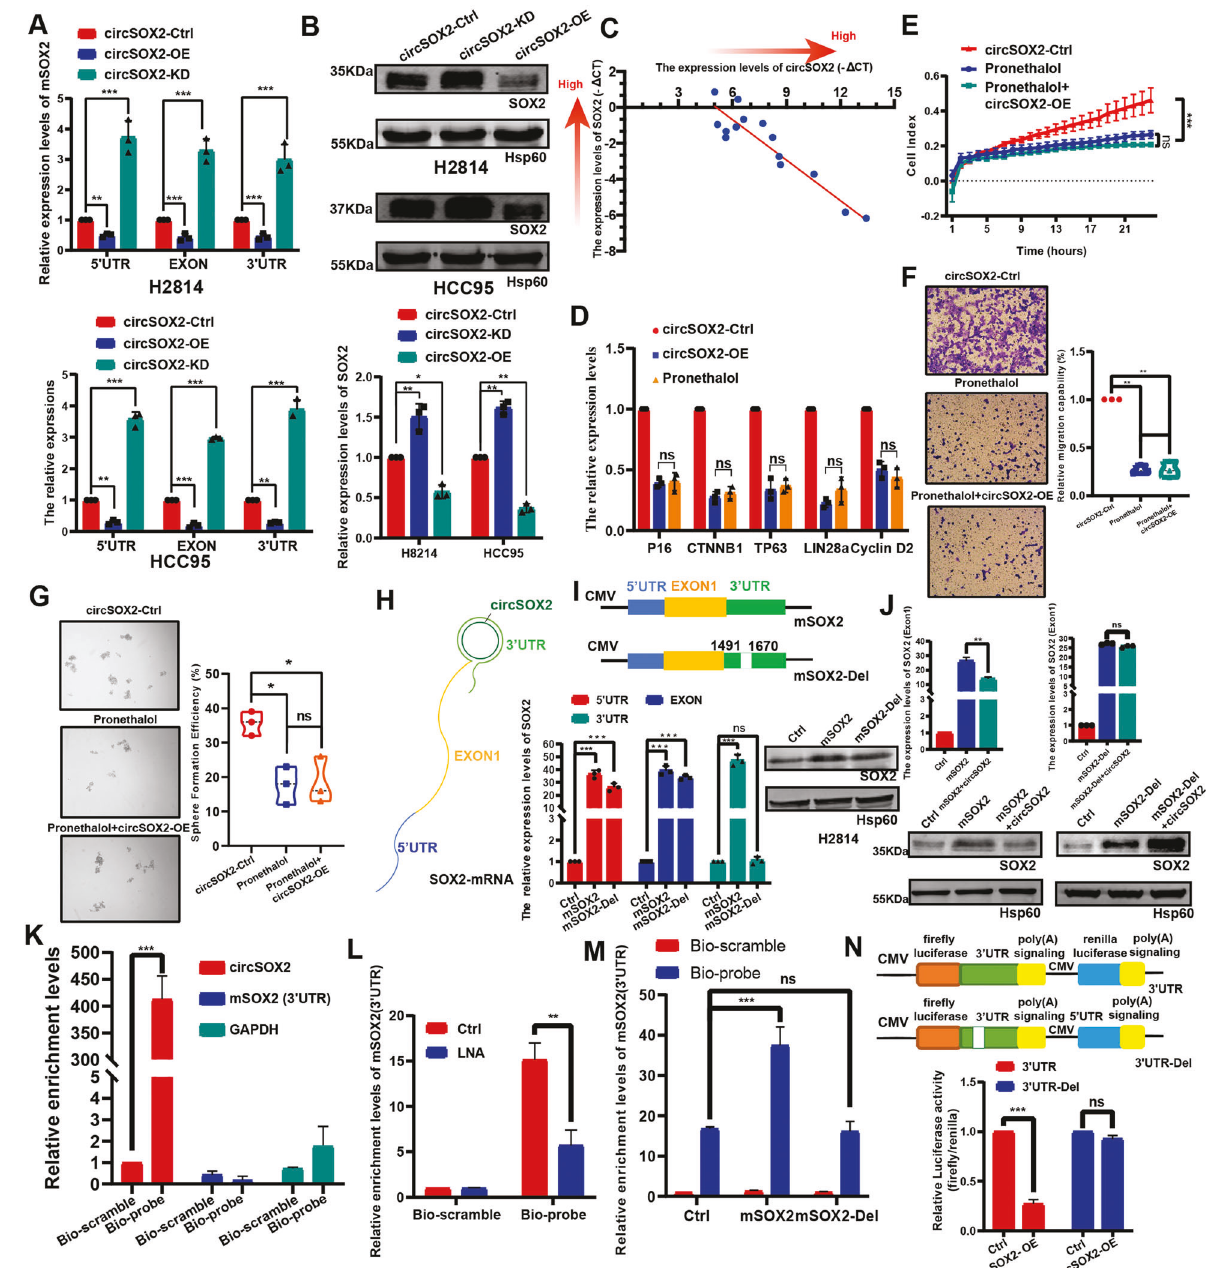
Fig. 4 CircSOX2 was a self-restriction circRNA of the SOX2 gene in SOX2-ampli fi ed LUSC. A and B QRT-PCR and western blot assays revealed that circSOX2 suppressed the expression level of SOX2 coding transcript (mSOX2). C The expression of circSOX2 was negatively related to the expression level of mSOX2 in 14 SOX2-ampli fi ed LUSC tissues. D CircSOX2 decreased the expression of SOX2 downstream genes the same as the SOX2 transcript inhibitor, pronethalol. E – G RTCA, transwell, and sphere-forming assays indicated that the malignant progression suppression of circSOX2 was dependent on the expression of SOX2. H The diagram presented the hypothesis of reverse complete between circSOX2 and 3 ’ UTR of mSOX2. I The overexpressed plasmids of mSOX2 and mSOX2-Del was successfully constructed and identi fi ed by qRT-PCR and western blot assays. J CircSOX2 could not suppress the expression of mSOX2-Del. K The circSOX2 probe could specially bind to circSOX2. L The LNA, which targeted the complete sequence of mSOX2 3 ’ UTR, signi fi cantly decreased the binding between circSOX2 and mSOX2. M The mSOX2-Del plasmid could not increase the binding between circSOX2 and mSOX2 in LUSC cells. N The dual-luciferase reporter assays indicated that circSOX2 binds to the 3 ’ UTR of mSOX2 dependent on the reverse complete sequences. *** p < 0.001, ** p < 0.01, ns: no signi fi